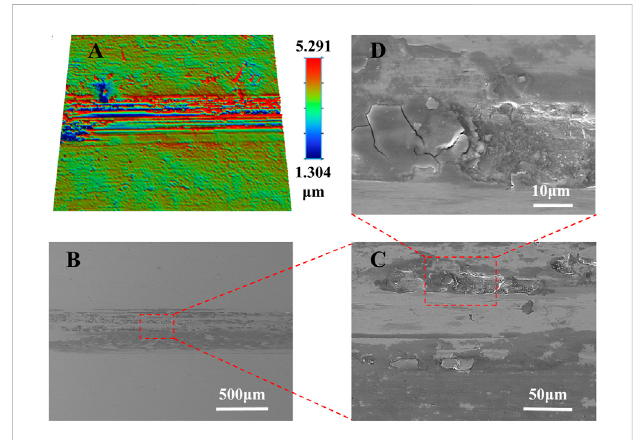
FIGURE 11 WearsurfaceoftheZrNbTiMoRHEA fi lmdepositedat150 W: (A) 3D image; (B) , (C) , and (D) SEM image.